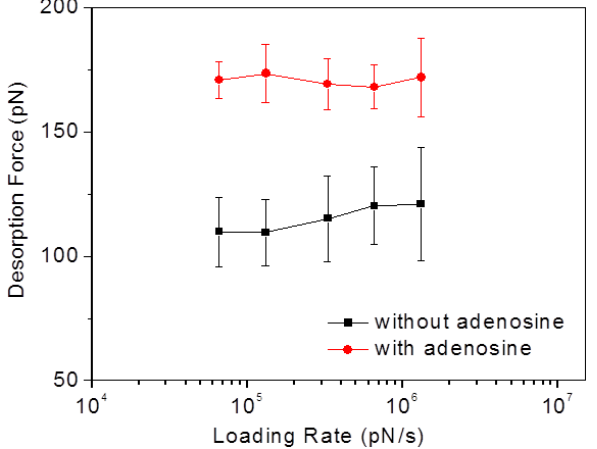
Figure 7. Mean aptamer/graphite desorption forces plotted logarithmically against the corresponding loading rates in binding buffer without and with